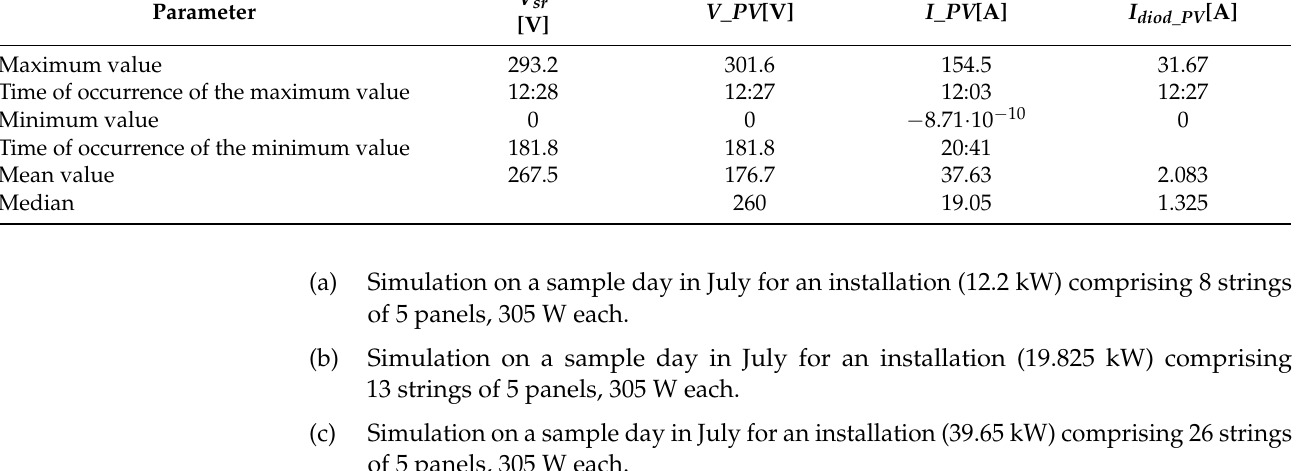
Figure 24. Daily waveform of the power supplied (19.825 kW) to the network on a sample day in July. c) Simulation on a sample day in July for an installation (39.65 kW) comprising 26 strings of 5 panels, 305 W each.